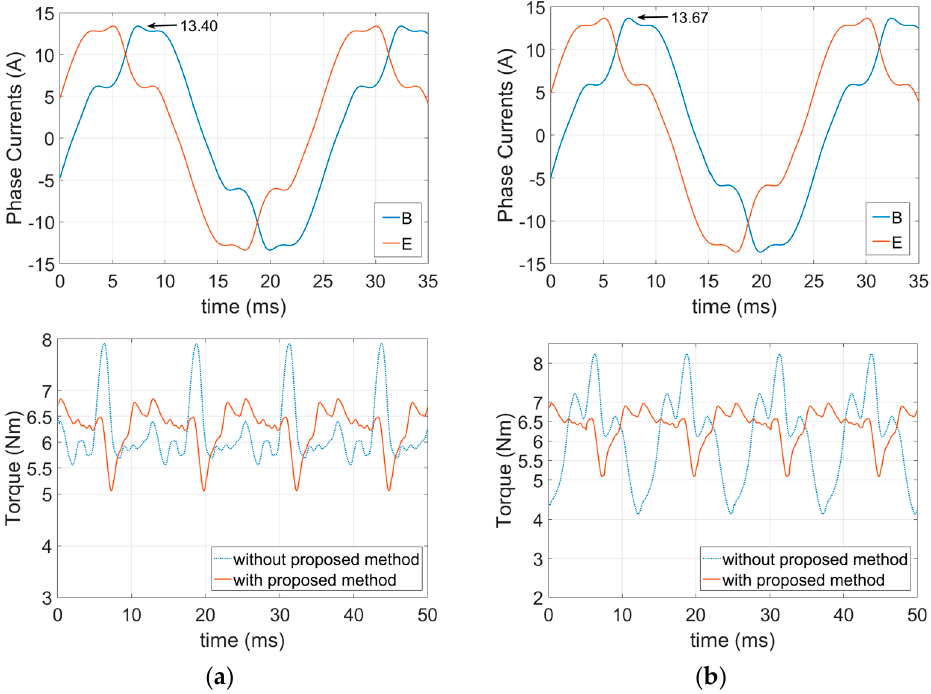
Figure 15. FEA torque waveforms for the fault-tolerant control currents of the ATPOC condition with and without the proposed method: ( a ) Only fundamental; ( b ) fundamental plus third har- monic.